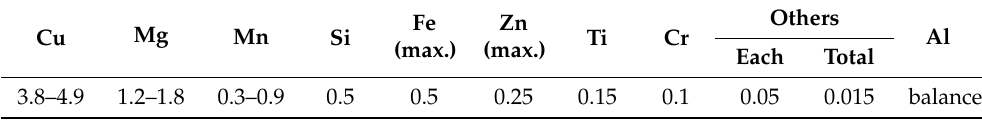
Table 1. Chemical composition of the EN AW-2024-T3 aluminium alloy (wt.%).